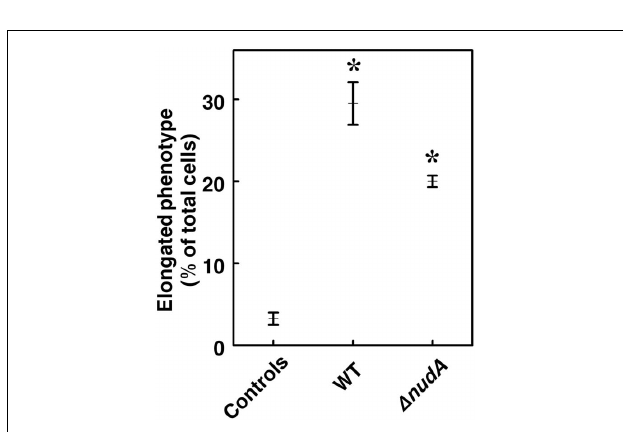
FIGURE 6 | Percentage ofAGS cells with elongated (“hummingbird”) phenotype in cells infected withWT J99 and Δ nudA H. pylori compared to control uninfected cells. Values are Means ± SEM.The percentage of cells with abnormal phenotype is higher in both types of infection (* p < 0.001), and also significantly higher in infection withWT H. pylori than with the Δ nudA mutant ( p < 0.01).